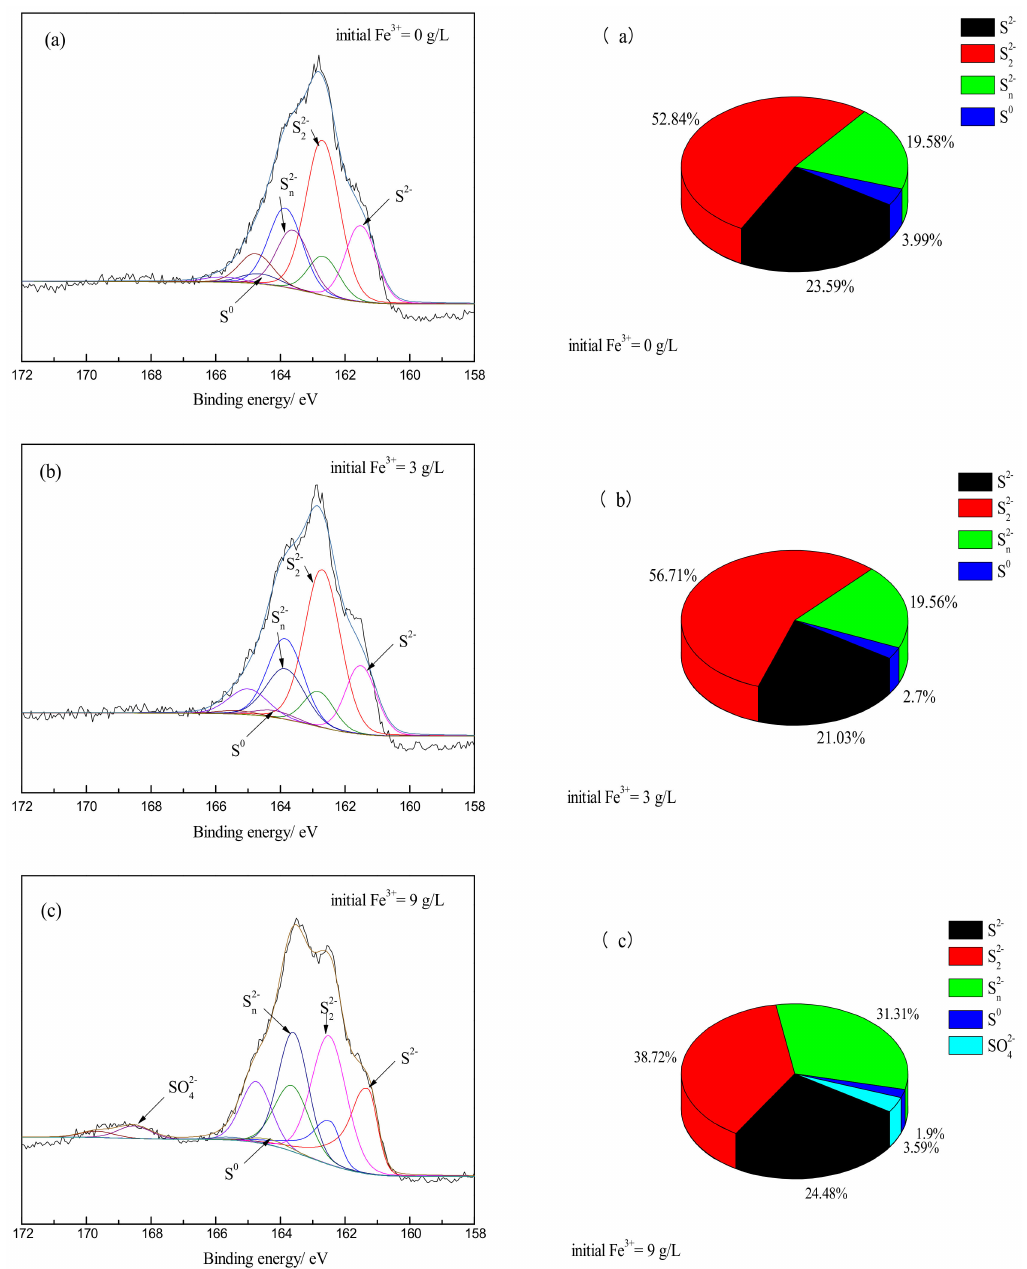
Figure 6. S 2p XPS spectra of leached samples with di ff erent conditions: ( a ) initial Fe 3 + = 0 g / L, leached for 14 days; ( b ) initial Fe 3 + = 3 g / L, leached for 14 days; ( c ) initial Fe 3 + = 9 g / L, leached for 52